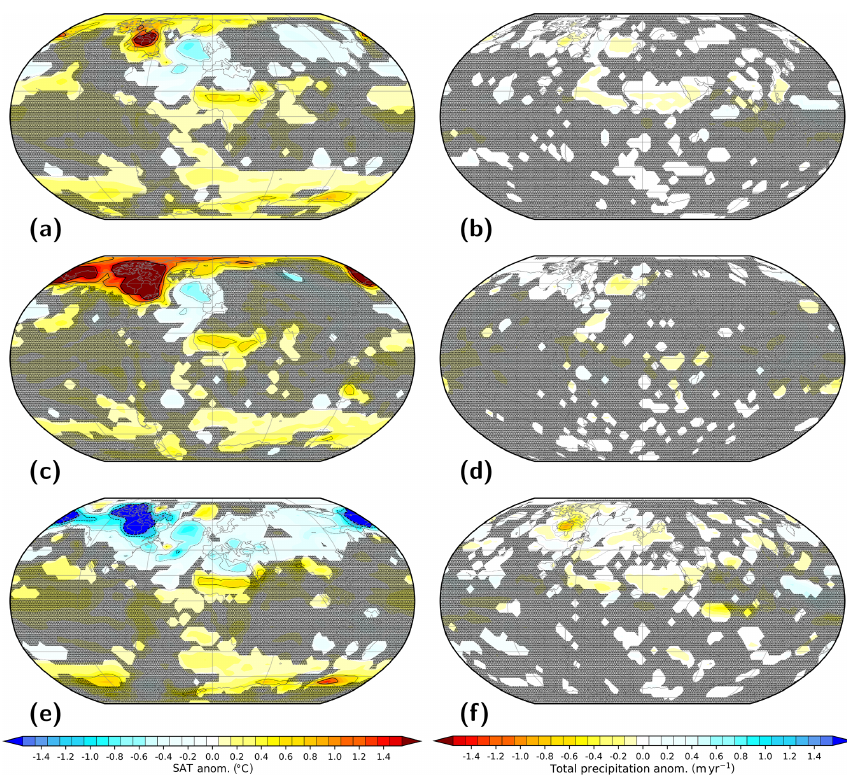
Figure 28. Impact of changes in Northern Hemisphere gateways on simulated mid-Pliocene surface air temperature (SAT, a, c, e ) and total precipitation (b, d, f) . Shown are anomalies Eoi400_GW with respect to Eoi400 for (a, b) annual mean, (c, d) boreal winter (DJF) mean, and (e, f) boreal summer (JJA) mean. Contours illustrate isolines of − 1 . 5 (dashed, thick), − 1 . 0 (dashed), − 0 . 5 (dashed, thin), 0.0 (dotted, thin), 0.5 (solid, thin), 1.0 (solid), and 1.5 (solid, thick) in degrees Celsius (a, c, e) and metres per year (b, d, f) . We define SAT as the temperature at a height of 2m above the surface and total precipitation as the sum of large-scale and convective precipitation in both solid and fluid phases. In hatched regions the anomaly is insignificant at the 95% confidence interval based on a t